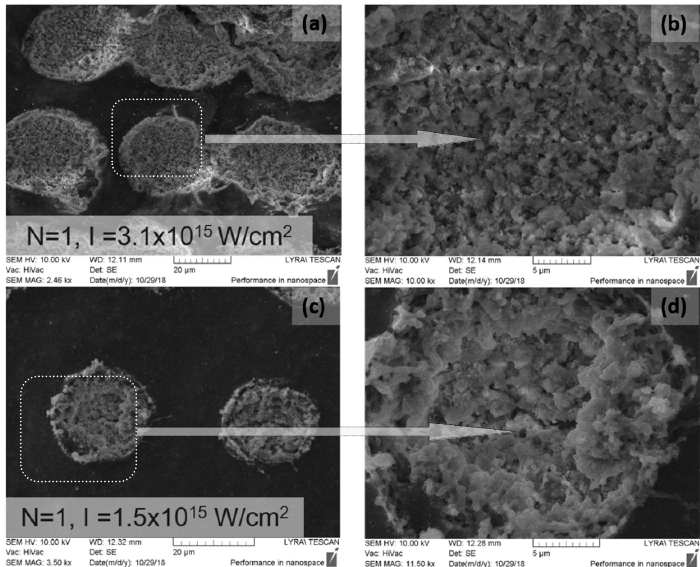
Figure 6. SEM images of 70/30% Ch/Hap + 1% ZrO 2 thin films treated with fs laser radiation at ( a ) N = 1, I = 3.1 × 10 15 W/cm 2 , ( b ) and ( d ) close-up of laser treated circular area, ( c ) N = 1, I = 1.5 × 10 15 W/cm 2 .